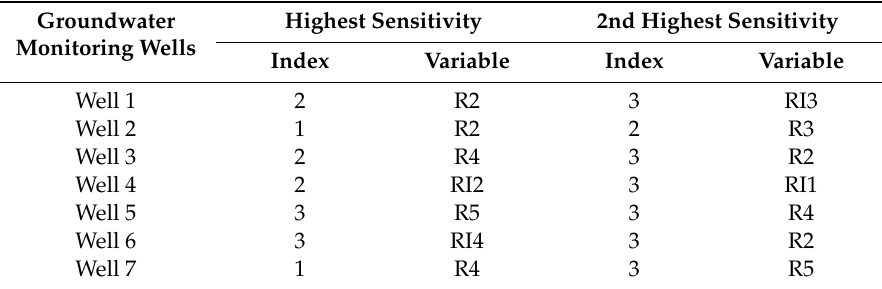
Table 7. Highest and 2nd highest